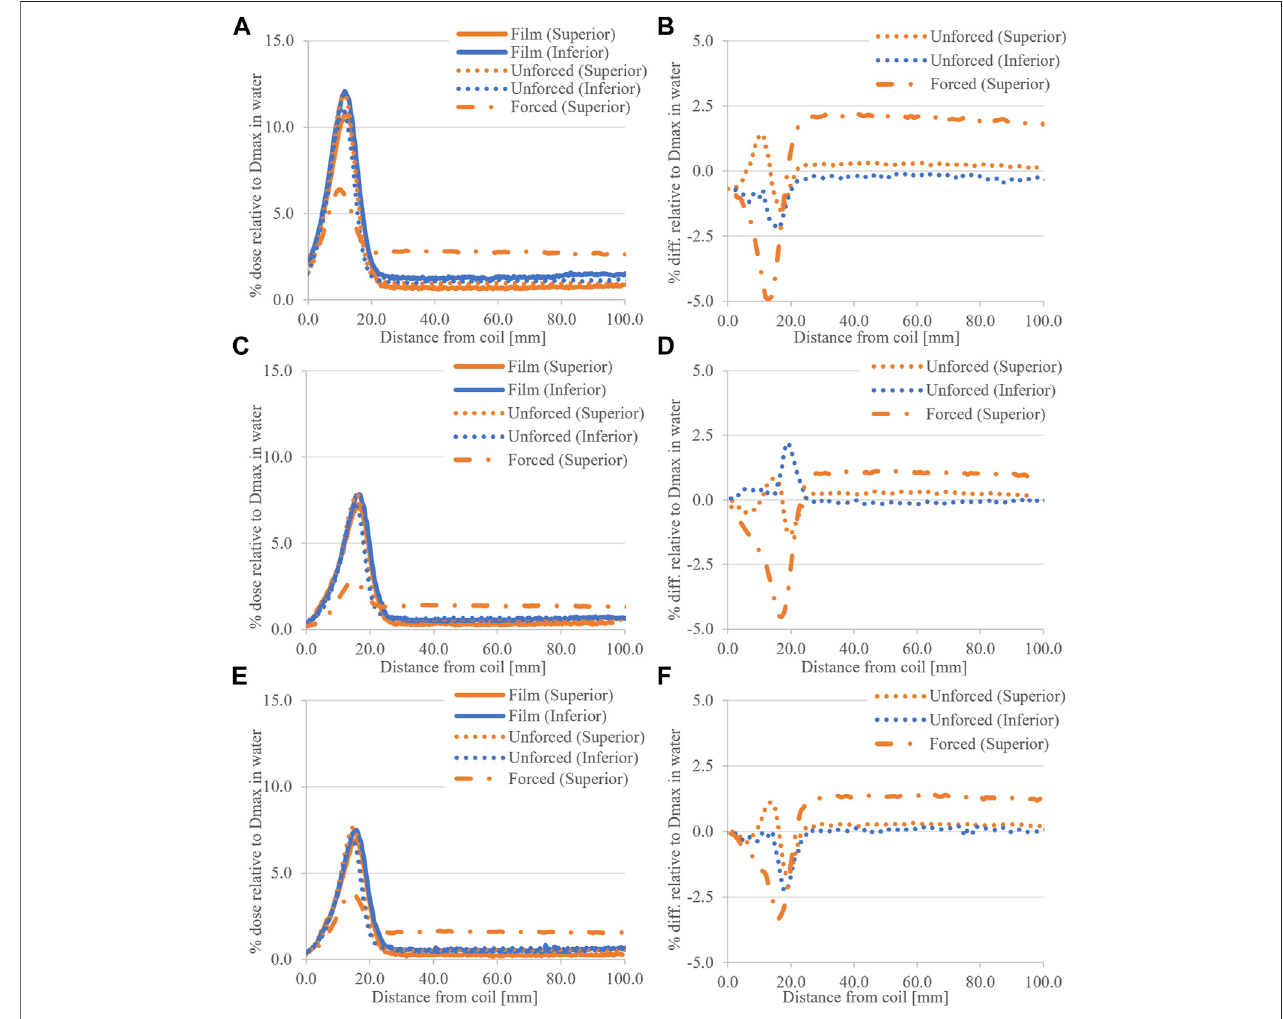
FIGURE 7 | Small fi eld coil ESE doses, calculated and measured, for (A) the 5.0 × 5.0 cm 2 fi eld with (B) associated difference plot. (C) shows the 5.0 × 3.0 cm 2 results and (D) associated differences, and similarly with (E) the 3.0 × 3.0 cm 2 results and (F) difference plots.